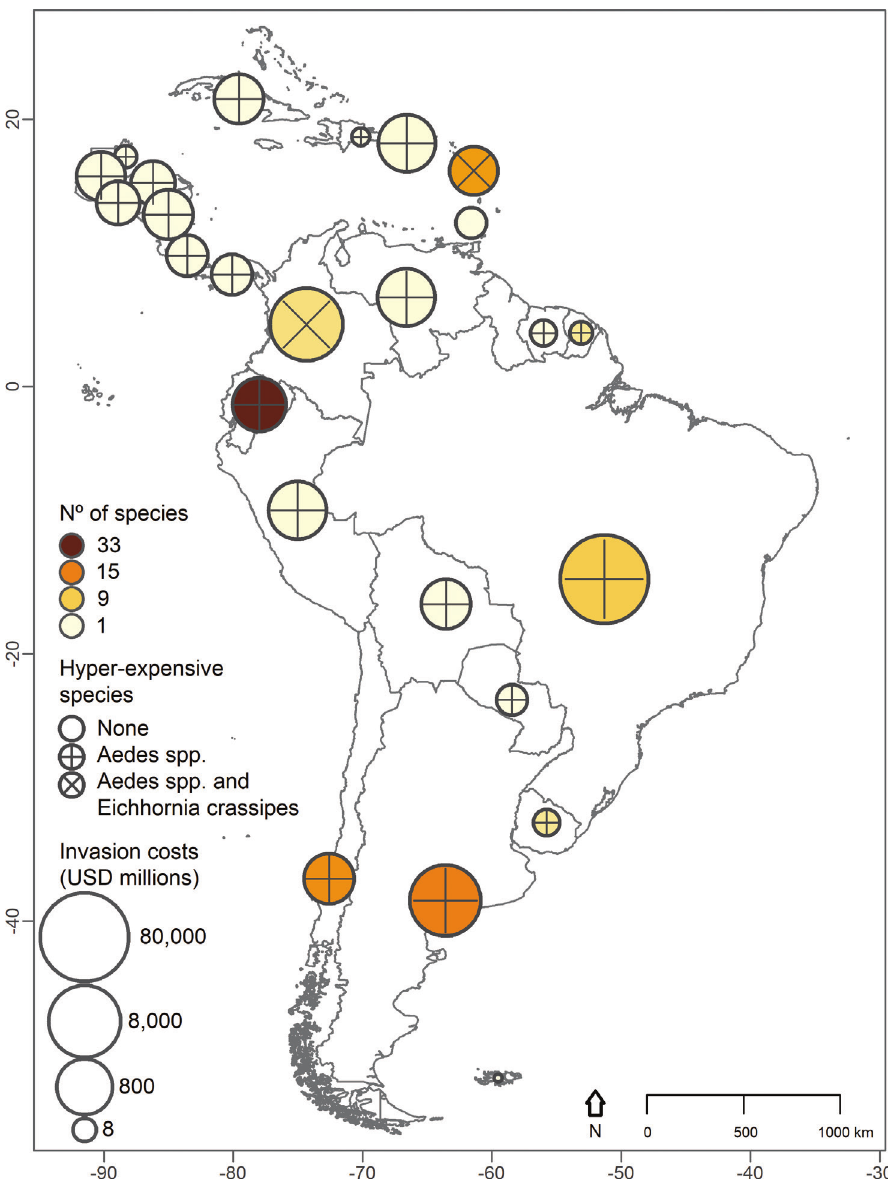
Figure 1. Map of Central and South America showing the number of invasive alien species registered in the InvaCost database (colour of circles), countries where costs with the hyper-costly taxa Aedes spp. and Eichhornia crassipes were related (crosses in the circles), and costs per country (size of the circles). Aedes spp. represents Aedes aegypti and Aedes albopictus